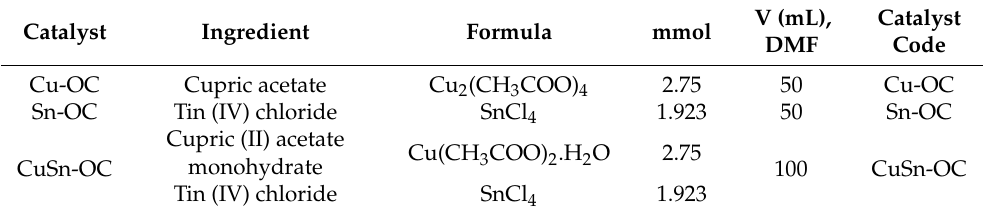
Table 1. The catalyst composition with the reaction